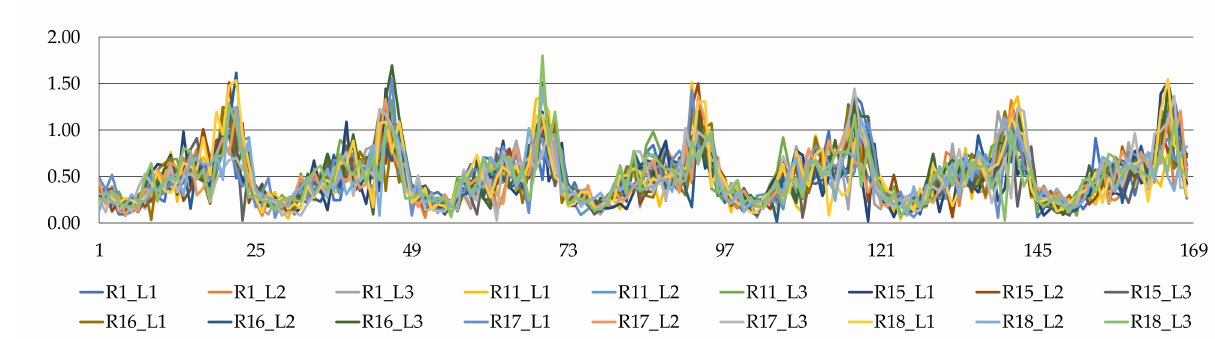
Figure 4. Weekly asymmetric load profile (p.u. of peak